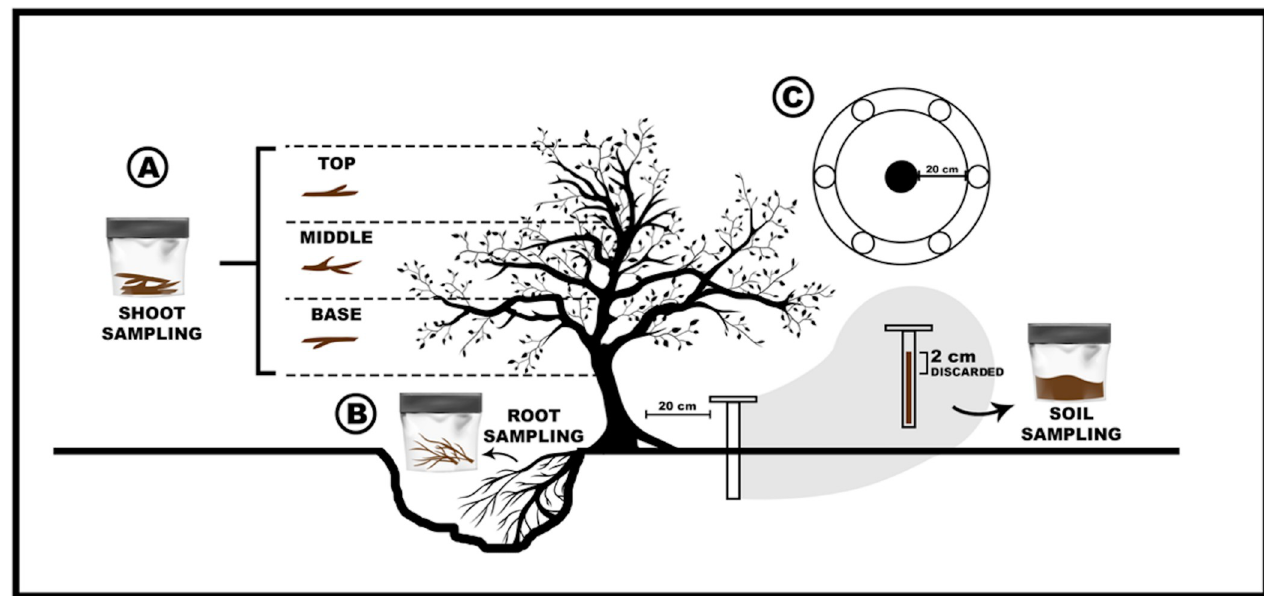
Fig 1. Schematic overview of the sampling strategy of soil and tree samples in a ‘HoneyCrisp’ orchard block with rapid apple decline (RAD). Sampling and pooling of shoots from three different positions in the tree canopy (top, middle, and base) (A), Sampling of root tissue and rhizosphere (B). Soil sampling for the analysis of soil physical and chemical properties